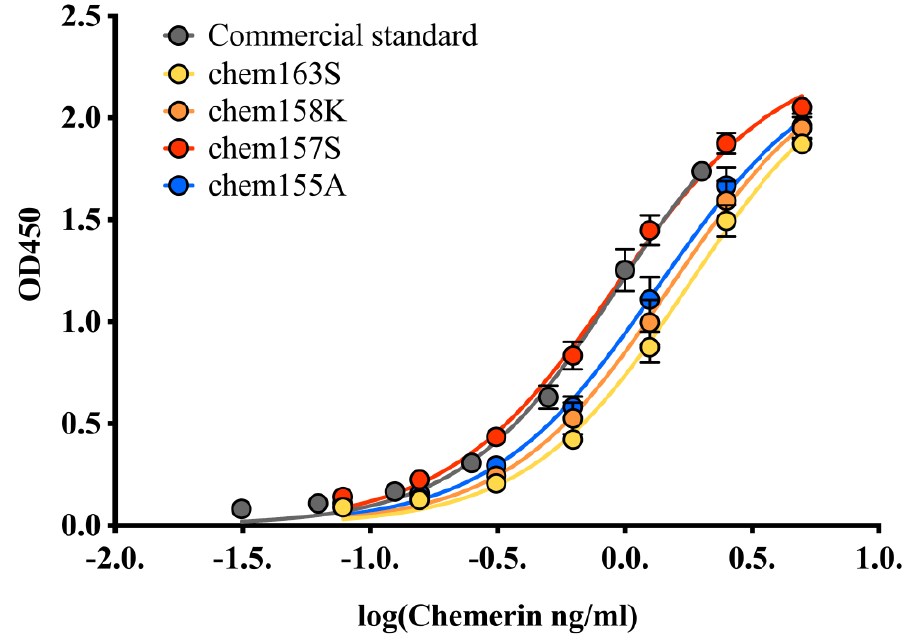
Figure 6. Comparison of the potency of different chemerin forms produced in a mammalian expres- sion system [27] in a commercial ELISA. Standard curves in that commercial ELISA with the E. coli - derived, Glu 21 – Ser 157 chemerin standard provided in the ELISA kit (gray), recombinant chem163S (yellow), recombinant chem158K (orange), recombinant chem157S (red), and recombinant chem155A (blue). Protein concentration for each standard protein was measured by Bradford assay prior to ELISA.